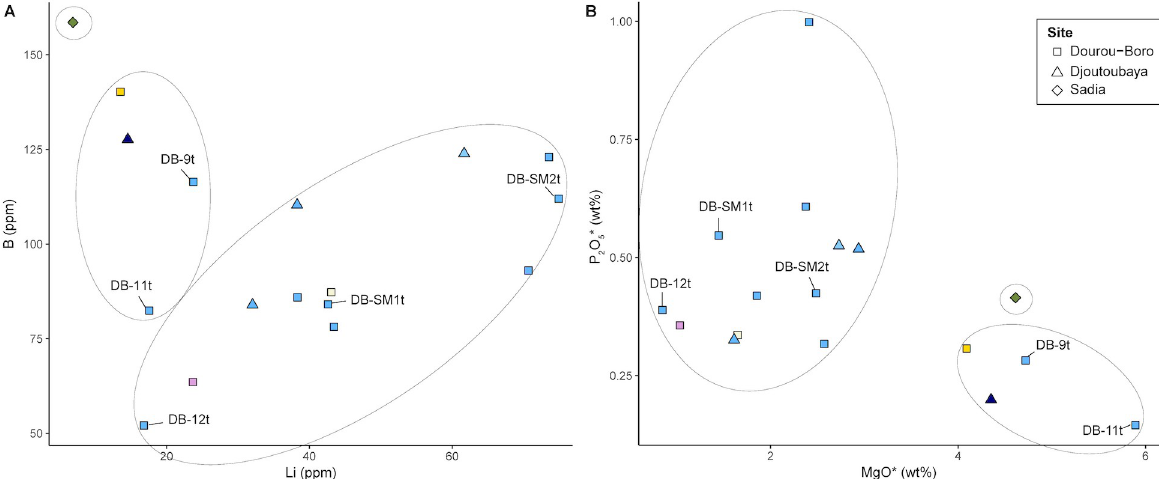
Fig 7. Concentrations of the elements linked to the flux in the analysed glass beads. Boron versus lithium (A) and phosphorus pentoxide versus magnesia (B) suggest different origins for the plant ash used in production.